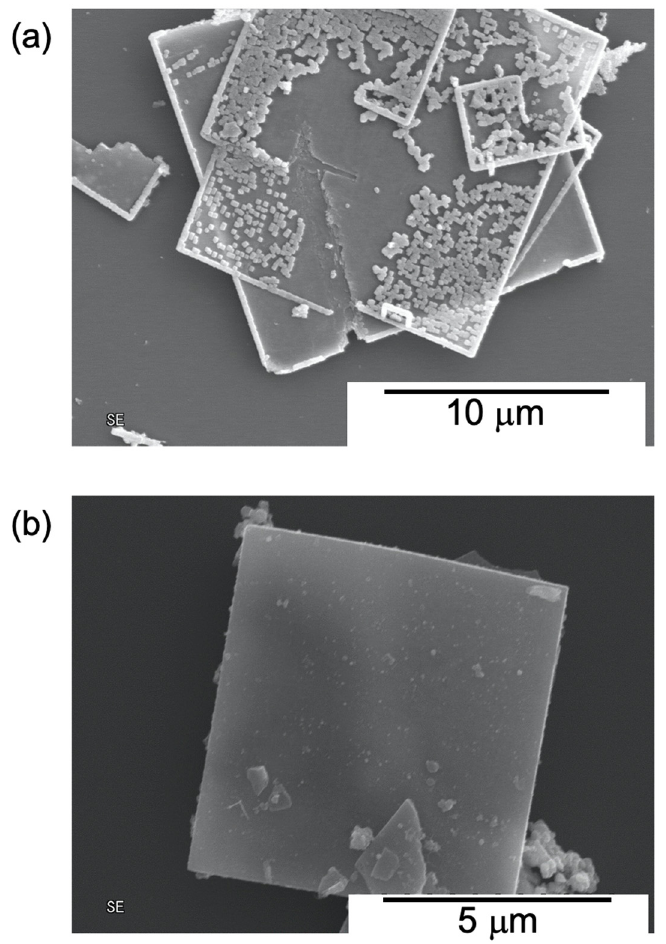
Figure 2. SEM images of ( a ) TiO 2 and ( b ) SWCNT/TiO 2 /Pt. The formation of SWCNT/TiO 2 /Pt nanohybrids was confirmed by absorption, 2D excitation/emission, and Raman spectra. The absorption spectra of SWCNT/TiO 2 /Pt (blue line) exhibit the characteristic absorption bands derived from SWCNTs that appeared at 400–700 nm (Figure 3). The absorption originating from (6,5)SWCNT ( λ max 570 nm) along with a small shoulder at around 670 nm originating from (8,3) and (7,5)SWCNTs were observed, almost the same as that of SWCNT/BDD-dendrimer(COOH) (orange line). Two-dimensional excitation/emission spectra show the quenching of the fluorescence of SWCNTs after the hybridization with TiO 2 /Pt due to photoinduced electron transfer from SWCNTs to TiO 2 (Figure S4).